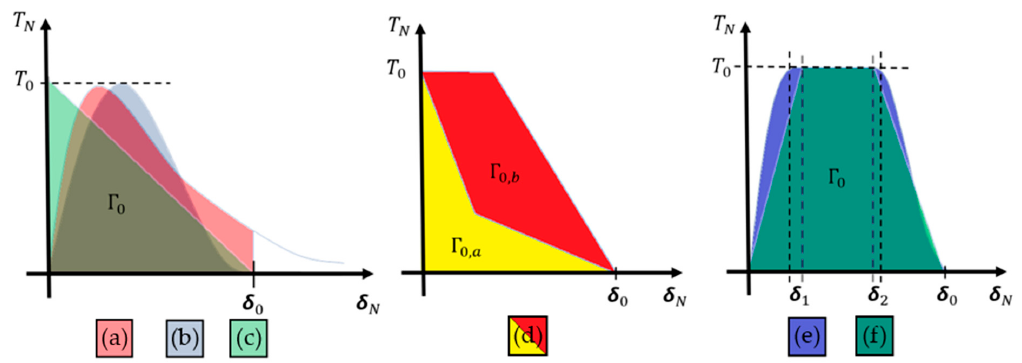
Figure 33. Typical traction separation laws according to: ( a ) Needleman 1987, ( b ) Needleman 1990, ( c ) Hillerborg 1976, ( d ) Bazant 2002, ( e ) Scheider and Brocks 2003, ( f ) Tvergaard and Hutchinson 1992.